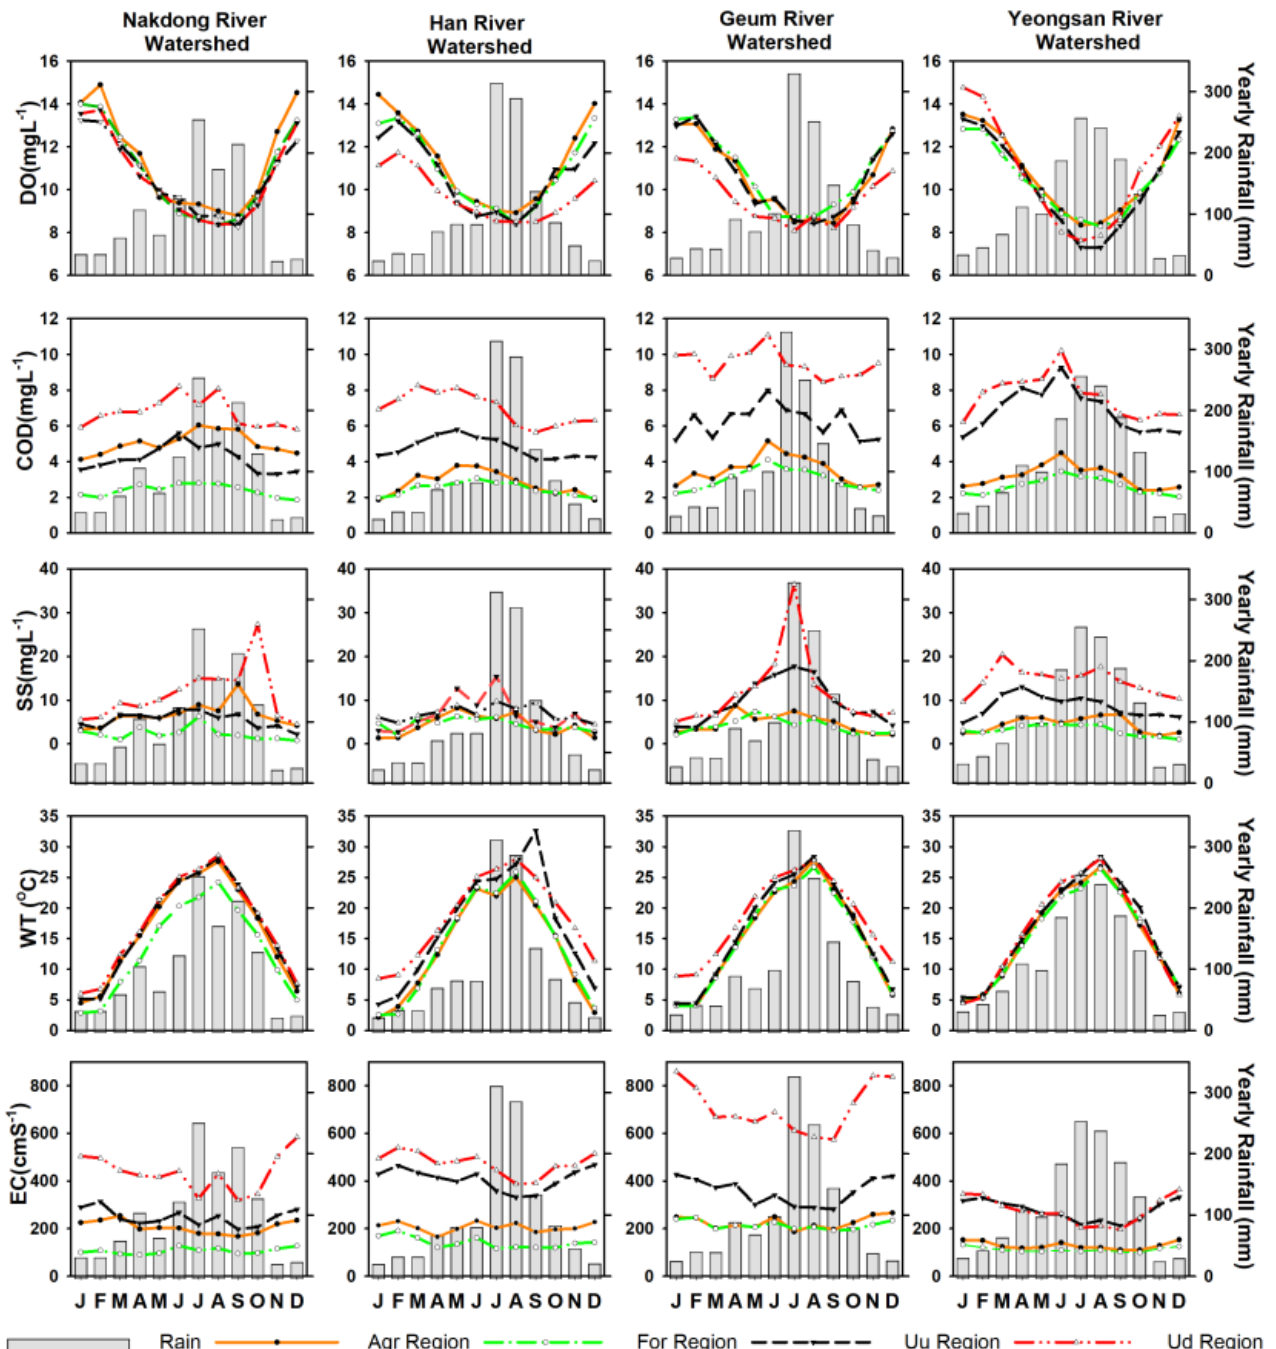
Figure 3. Seasonal patterns of dissolved oxygen (DO), chemical oxygen demand (COD), suspended solids (SS), water temperature (WT), and electric conductivity EC with monthly rainfall (mm) for 2016 – 2020 in 64 stream sites. (Each of the four land use patterns is divided into the four river watersheds.